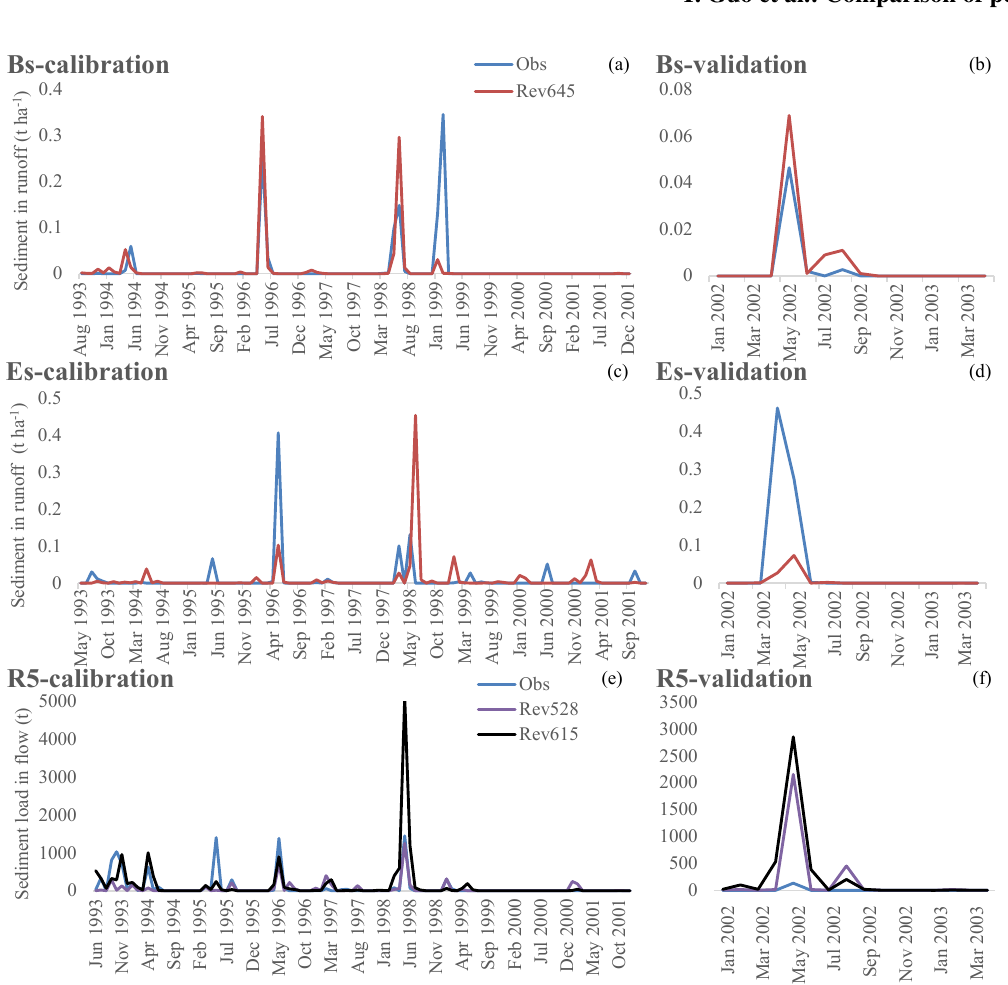
Figure 5. Calibration and validation results for monthly sediment losses in surface runoff at sites Bs (a, b) and Es (c, d) , and monthly sediment losses in flow at site R5 (e, f) . Obs and Revs. 528, 615, and 645 represent Observed and Revision 528, 615, and 645,